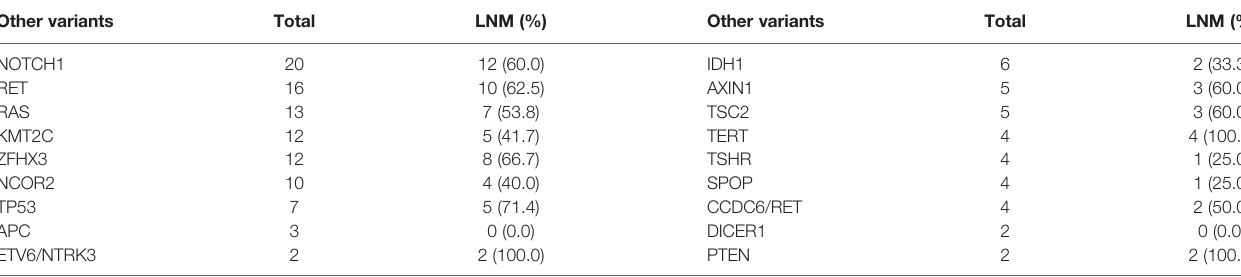
TABLE 3 | LNM in PTC patients with combined mutations in BRAF V600E and other genes. Other variants